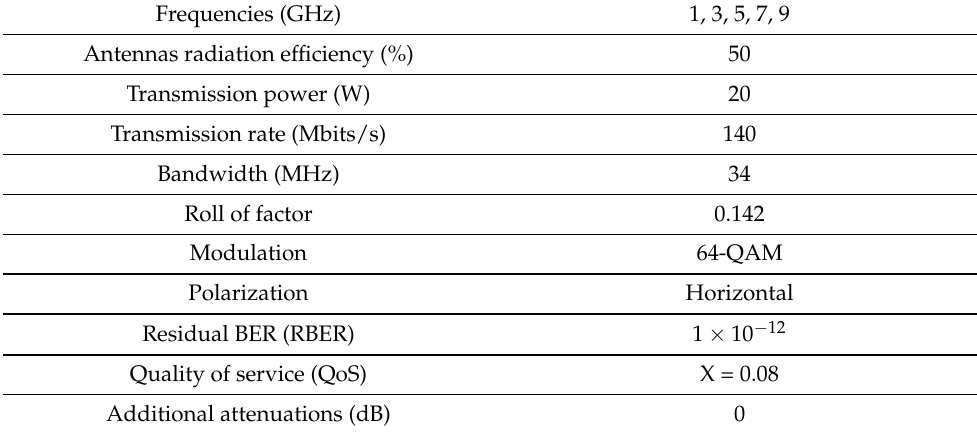
Table 2. Simulated terrestrial link